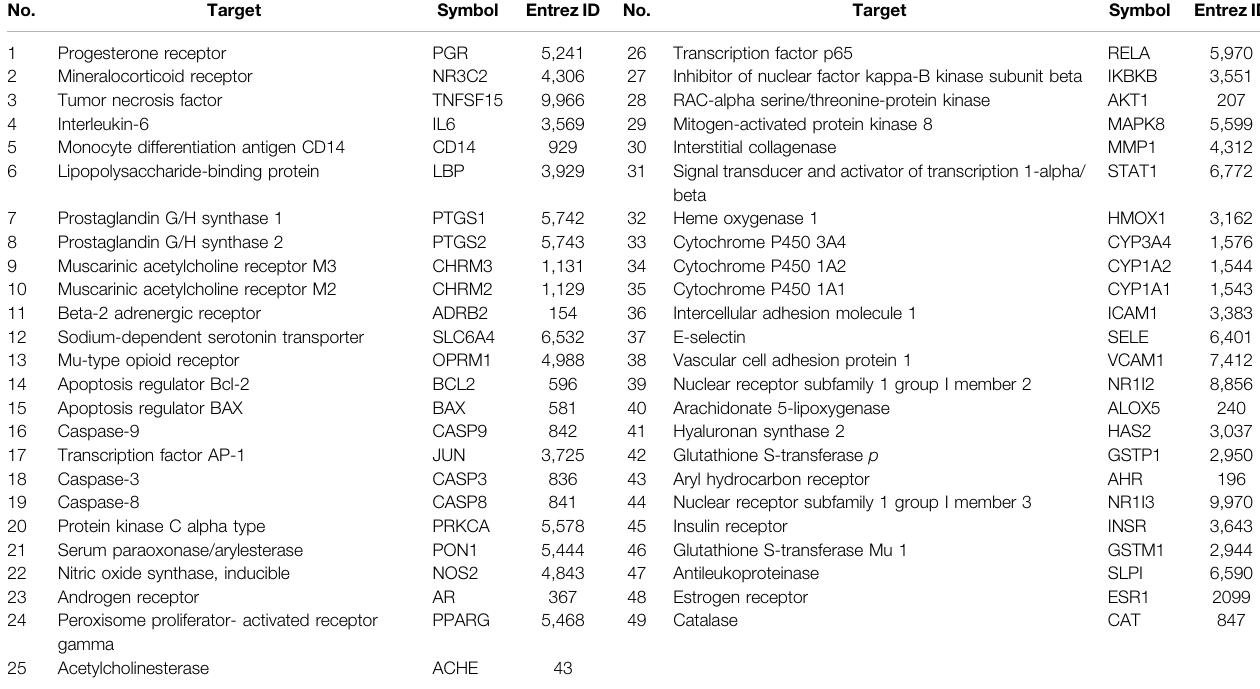
TABLE 2 | 49 potential target genes of WP therapy for RA.